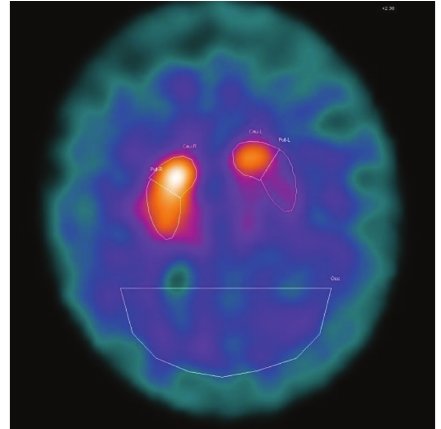
Figure 2: 123 I-FP SPECT showing a reduced tracer binding in the left striatum, with a more marked reduction in the